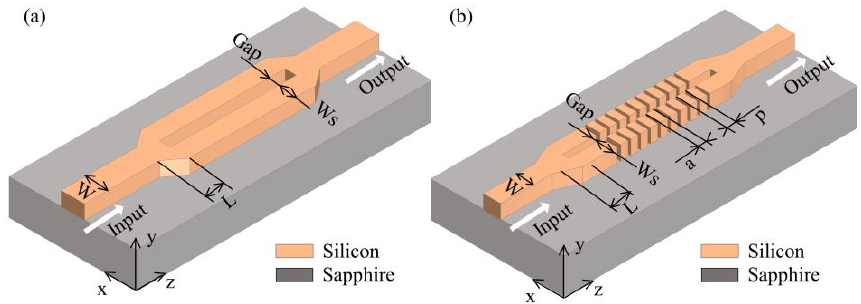
Figure 2. The structure diagram of the proposed sensor ( a ) slot waveguide; ( b ) SWGS waveguide.